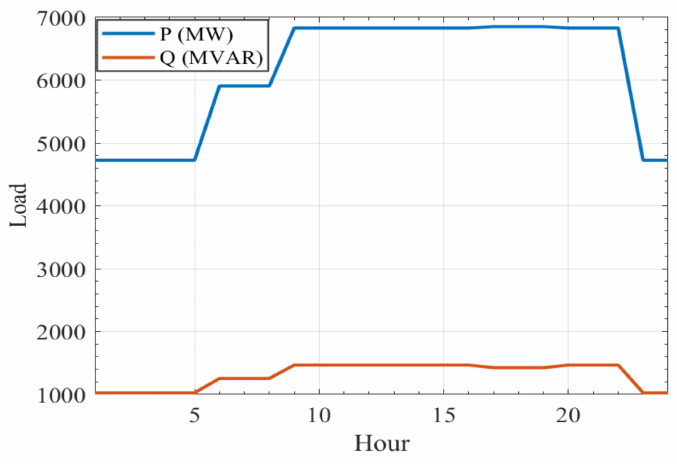
Figure 9. Hourly demand of the 118-bus system.